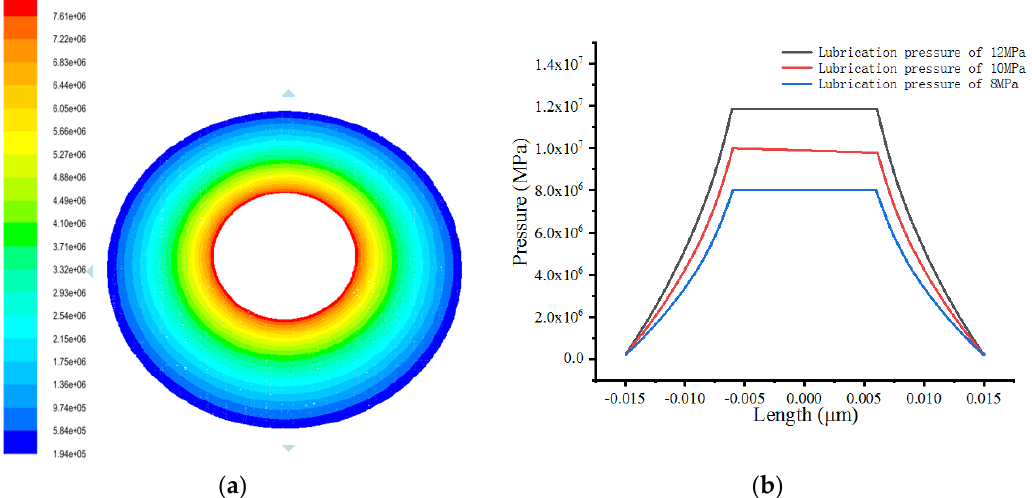
Figure 16. ( a ) The pressure distribution image of high-water-based lubrication film in friction pair, ( b ) the pressure distribution on the radial direction.